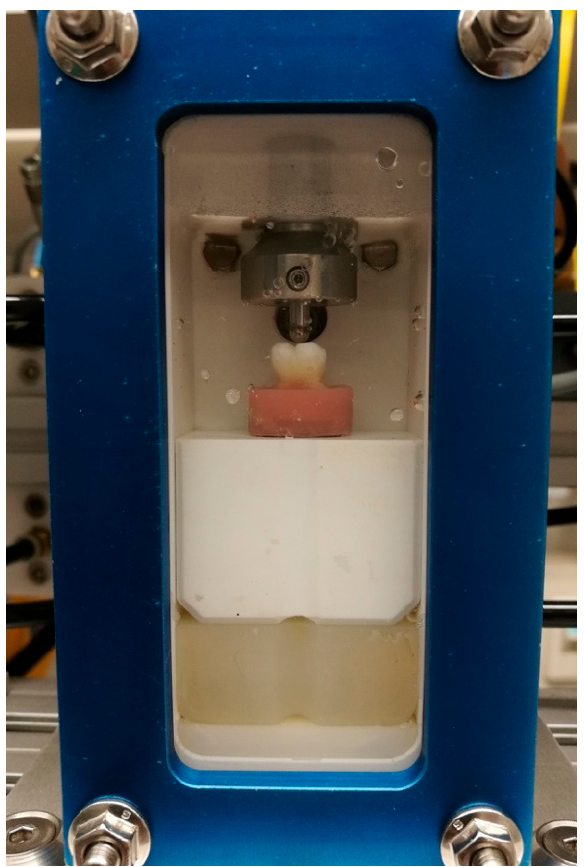
Figure 3. Test chamber of the computer-controlled masticator used for thermo-mechanical loading of the specimens.